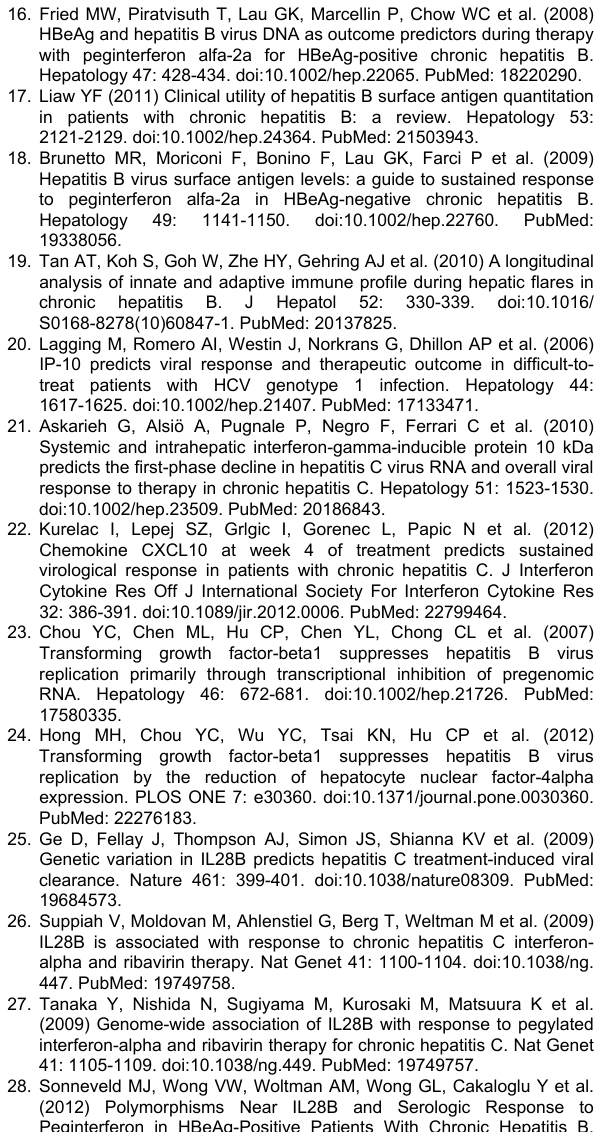
Table S2. Univariate and multivariate analyses of factors associated with sustained virological response in HBeAg- negative patients